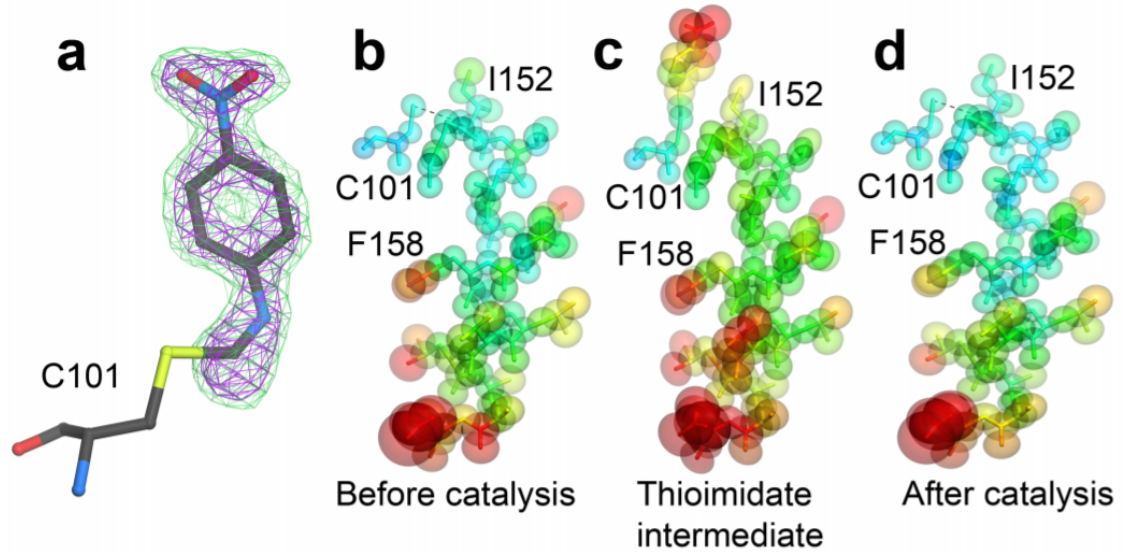
Figure 12. Observation of thioimidate intermediate formation and enhancement of ICH helix mobility: ( a ) omit mF o − DF c electron-density-difference map, and ( b,c,d ) anisotropic atomic displacement parameters (ADPs) from TLS models refined against the XFEL datasets are shown at the 75% probability level and colored according to B eq value (blue—less motion, red—more motion). Figure reproduced with permission from Dasgupta et al. [112]. Copyright (2019) National Academy of Sciences.